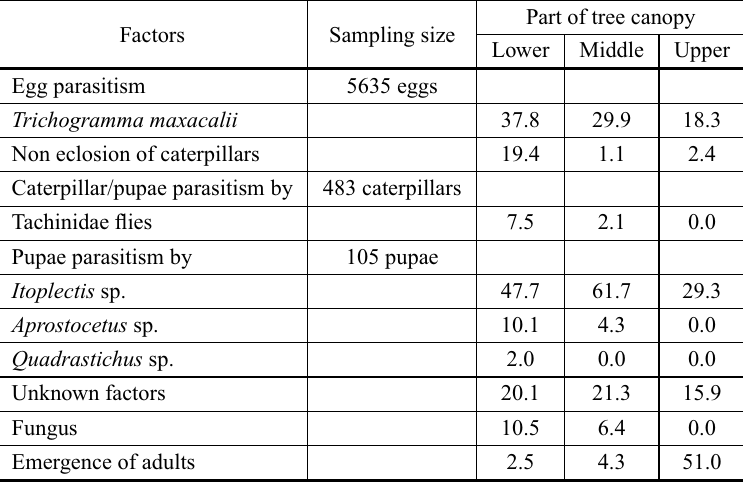
Percentage mortality of caterpillars and pupae by different factors and adult emer- gence of Euselasia eucerus (Lepidoptera: Riodinidae) collected in an Eucalyptus urophylla plantation in the Municipality of Caeté, Minas Gerais State,